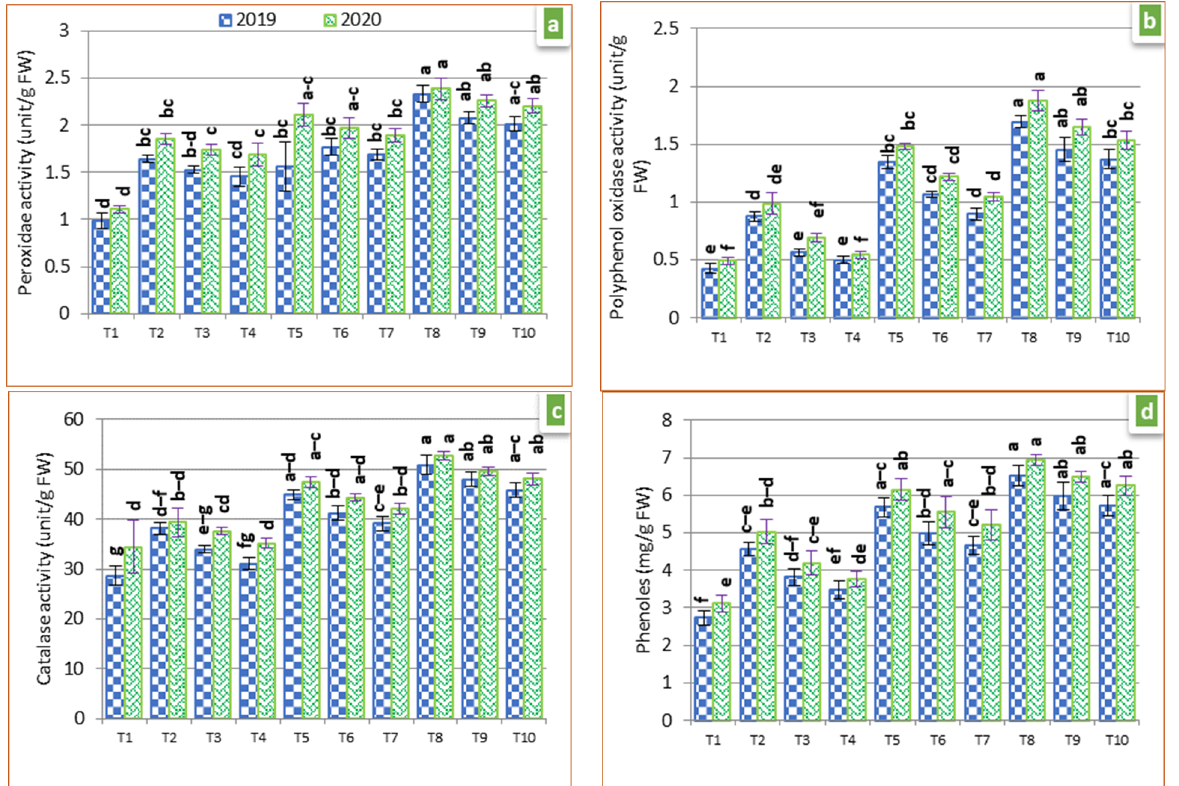
Figure 3. Antioxidant enzyme activities ( a – c ) and phenol concentration ( d ) of grapevine leave as affected by salinity (NaCl) and brassinolide (BL) during both growing seasons. Data represent the average of five replicates ± standard error. Different letters in each column indicate significant ( p ≤ 0.05) differences at p ≤ 0.05 according to Tukey’s HSD range at p ≤ 0.05. (FW, Fresh weight; mg, milligram; T1, 0 NaCl without BL application; T2, 1000 mg L − 1 NaCl without BL application; T3,